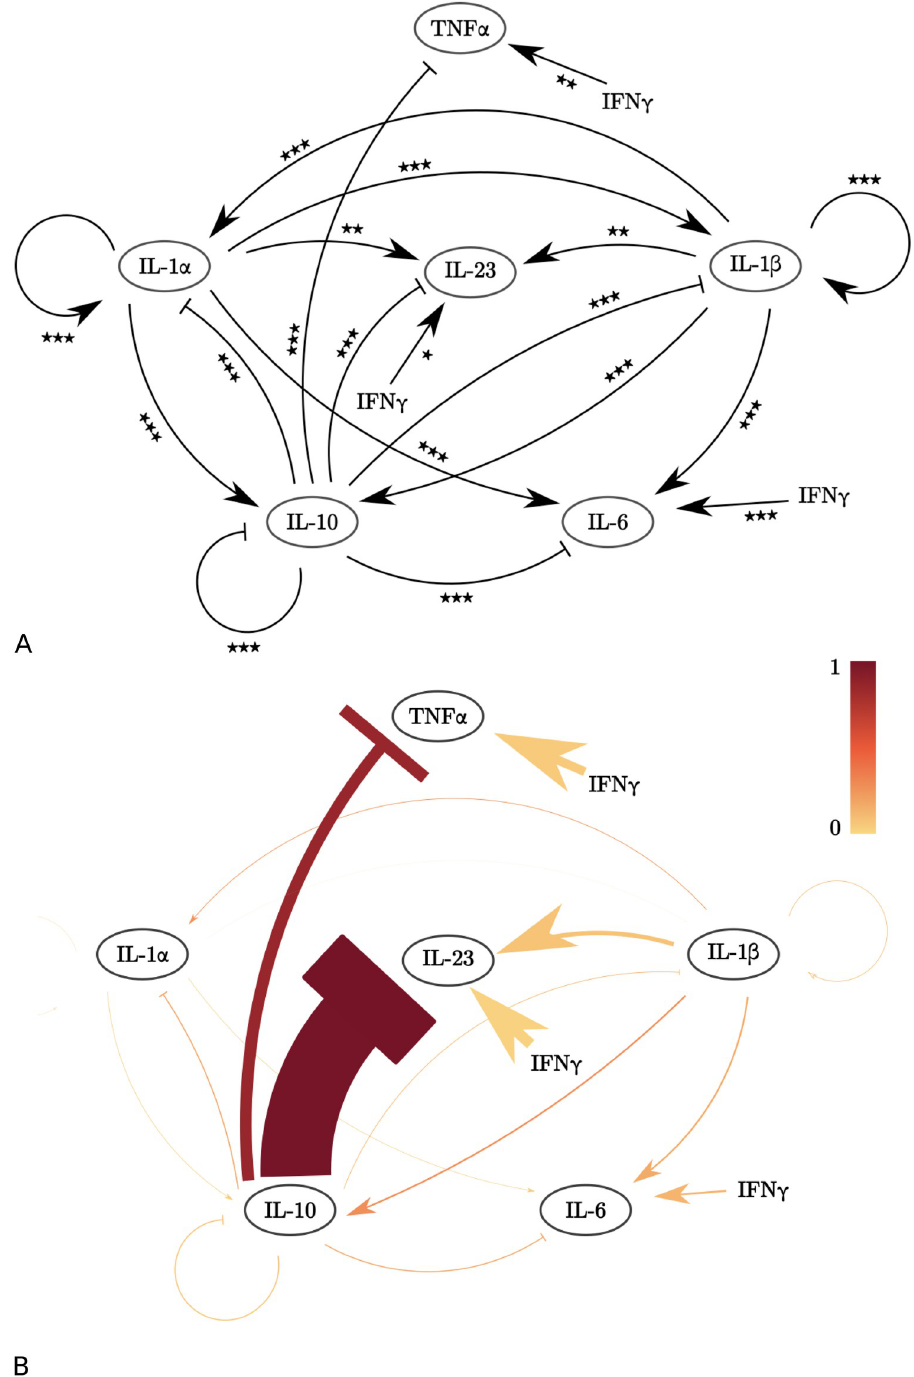
Fig 13. The IL23 model. A: Network extracted from the flow cytometry data set using statistical analysis (Section “Application to a dataset on IL23 regulation”) [35]. Using a two sample t-test, we test the hypothesis that the presence of inhibitor induces a change relative to the control: $ p � 0.05, $$ p � 0.01, $$$ p � 0.001, fdr corrected. B: The eighteen-edge network configuration selected by the AIC. Edge widths are proportional to the value of the corresponding edge parameter α and β that minimized D for the shown network configuration. Edges are coloured u , i v , i proportional to the increase in D when they are removed from the shown network configuration.